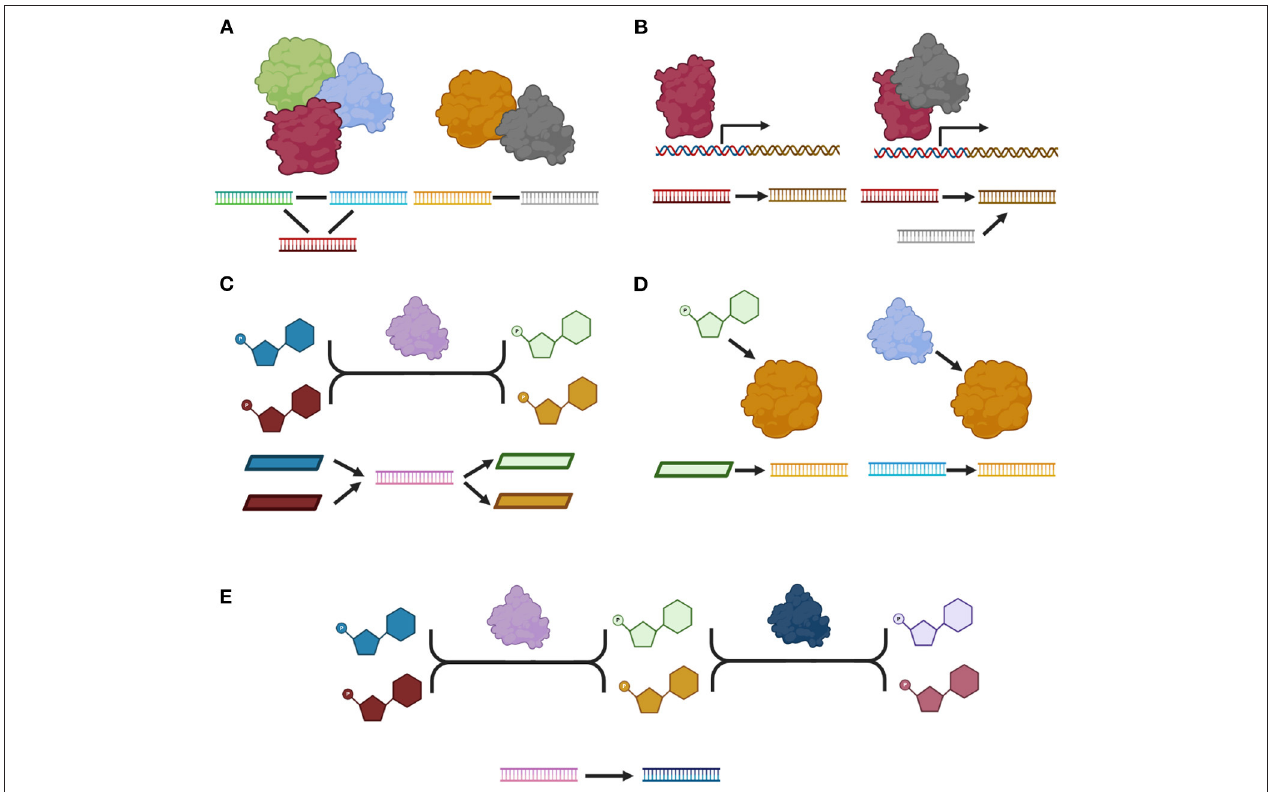
FIGURE 1 | A catalog of molecular interactions. (A) Protein-protein interactions: right side, a protein-complex, left side, a transient physical interaction. (B) Regulatory interactions. (C) An enzymatic reaction. (D) Metabolic interactions. (E) Two consecutive reactions. We show a molecular model for each type and subtype of interaction as well as its representation in our network. All proteins are represented by their corresponding gene in our network. Proteins are depicted as by globular forms, genes by straight ladders and metabolites by polygons. A gene that codifies for a specific protein, is represented as a straight ladder of the same color as the corresponding globular form. Transcriptional regulation is represented by a square arrow. Arrows represent directed interactions and plain lines represent undirected interactions. Only the most common subtype of interactions are shown. Figure made using BioRender